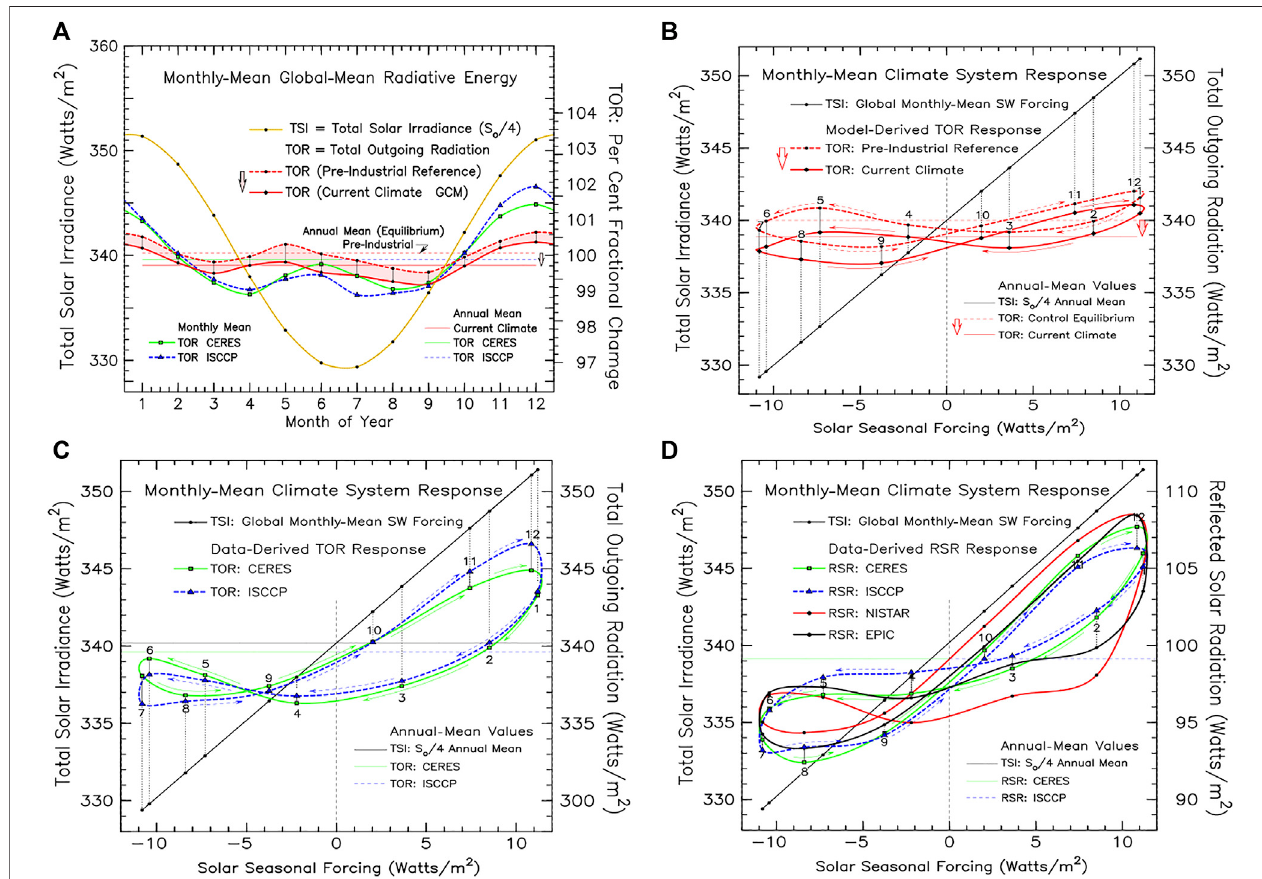
FIGURE7| SeasonalenergybalanceoftheEarthbetweentheincomingTotalSolarIrradiance(TSI)andtheTotalOutgoingRadiation(TOR)computedbytheGISS ModelE2for currentclimate (solid red line)and pre-industrial (reddash line) conditions withcomparison toCERES and ISCCP data (A) .The heavy yellow linedepicts the seasonal change in TSI radiative forcing. The CERES and ISCCP TOR determinations are depicted by the green and blue dash lines, respectively. (B) displays the GCM seasonalTORvariabilityinpinwheelformat(relativetotheSolarSeasonalForcing). (C) displaystheCERESandISCCPseasonalTORvariability,shownin (A) ,inthe samepinwheel format. (D) compares the re fl ected solar radiation RSRin pinwheel format between CERES and ISCCP results and NISTAR Band-B (solid red) and EPIC (black) derived SW fl ux results. The numbered black dots connected by the vertical dotted lines refer to the monthly-mean mid-points of TSI and the corresponding re fl ected SW fl